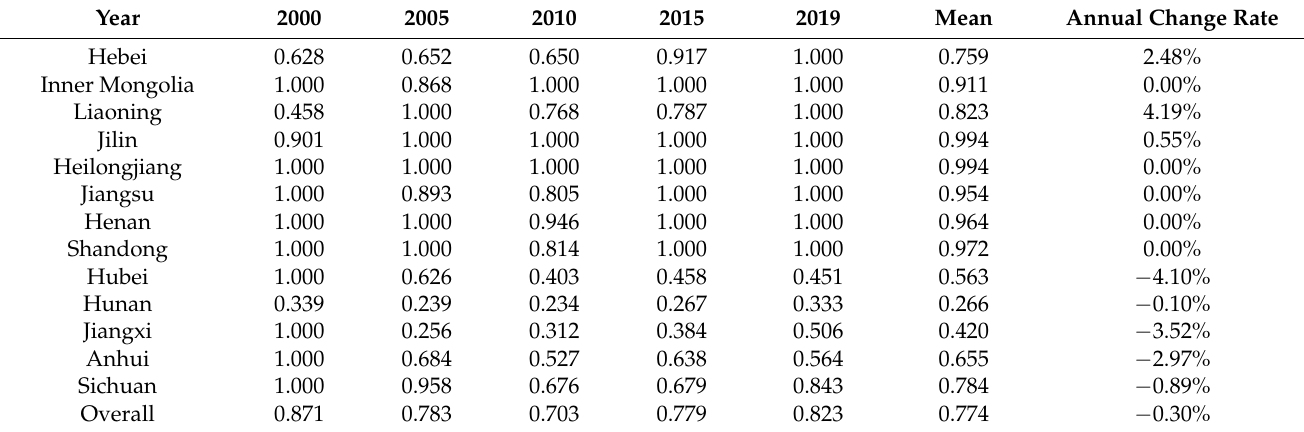
Table 3. NCSPC in the 13 Chinese principal grain-producing provinces in major